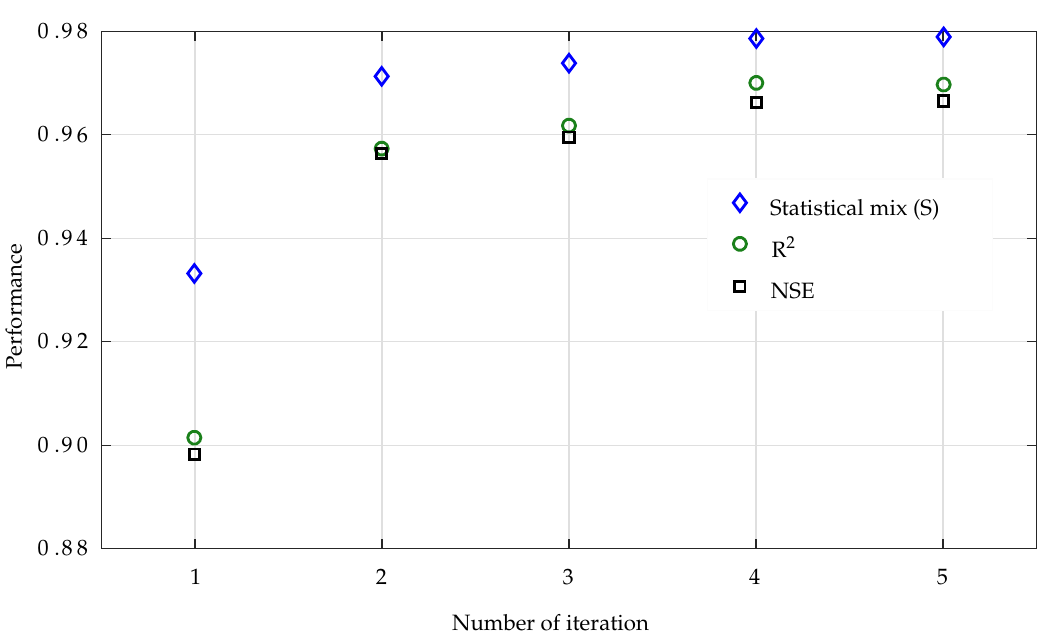
Figure 11. Statistical convergence of water depths for 1983’ event.